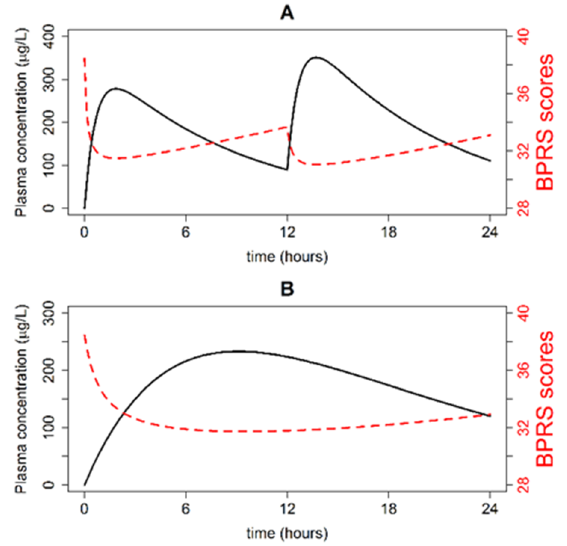
Figure 1. Quetiapine plasma concentration-time (black line) and Brief Psychiatric Rating Scale (BPRS) score time (red line) profiles in a typical patient following the administration of two 200 mg IR doses separated by 12 h ( A ) and one 400 mg XR dose ( B ).